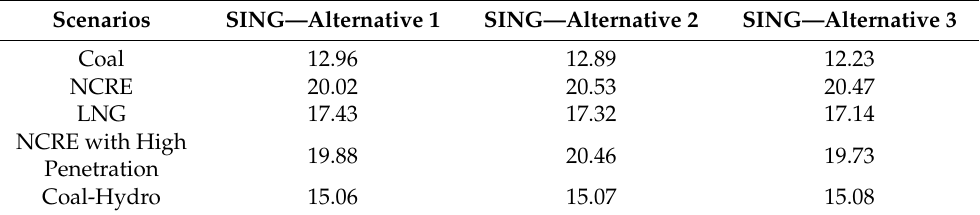
Table 5. Average free price differential in simulated scenarios for the SING, in US$/MWh.